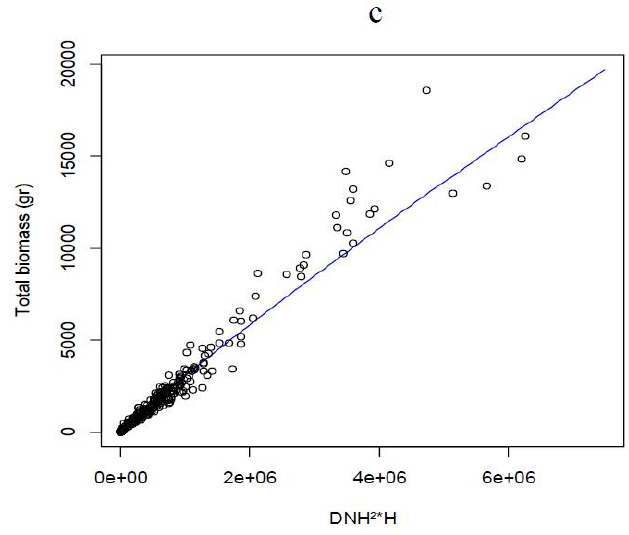
Figure 1. Total biomass as a function of its predictor variables for A. dealbata ( a ), A. melanoxylon ( b ), and A. mearnsii ( c ) DNH: diameter of the stem at neck height. H: stem height.